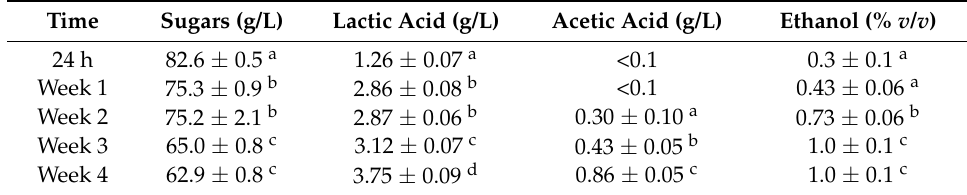
Table 2. Analysis of sugars, organic acids and ethanol in the pomegranate juices fermented by L. plantarum ATCC 14917 at first 24 h at 30 ◦ C and during storage at 4 ◦ C for 4